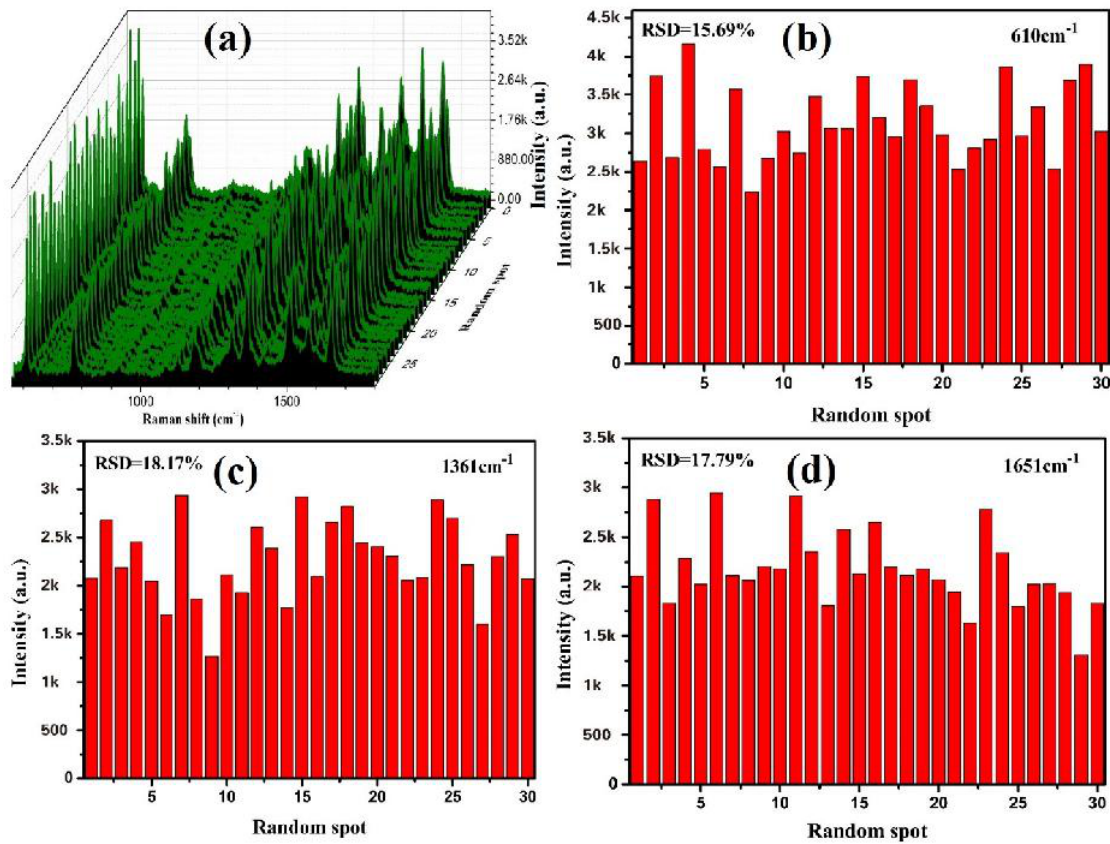
Figure 5. 3D Raman spectra and relative standard deviation (RSD) values of the selected peaks: ( a ) 3D Raman spectra from 30 random spots; ( b – d ) RSD values are at 610, 1361, and 1651 cm − 1